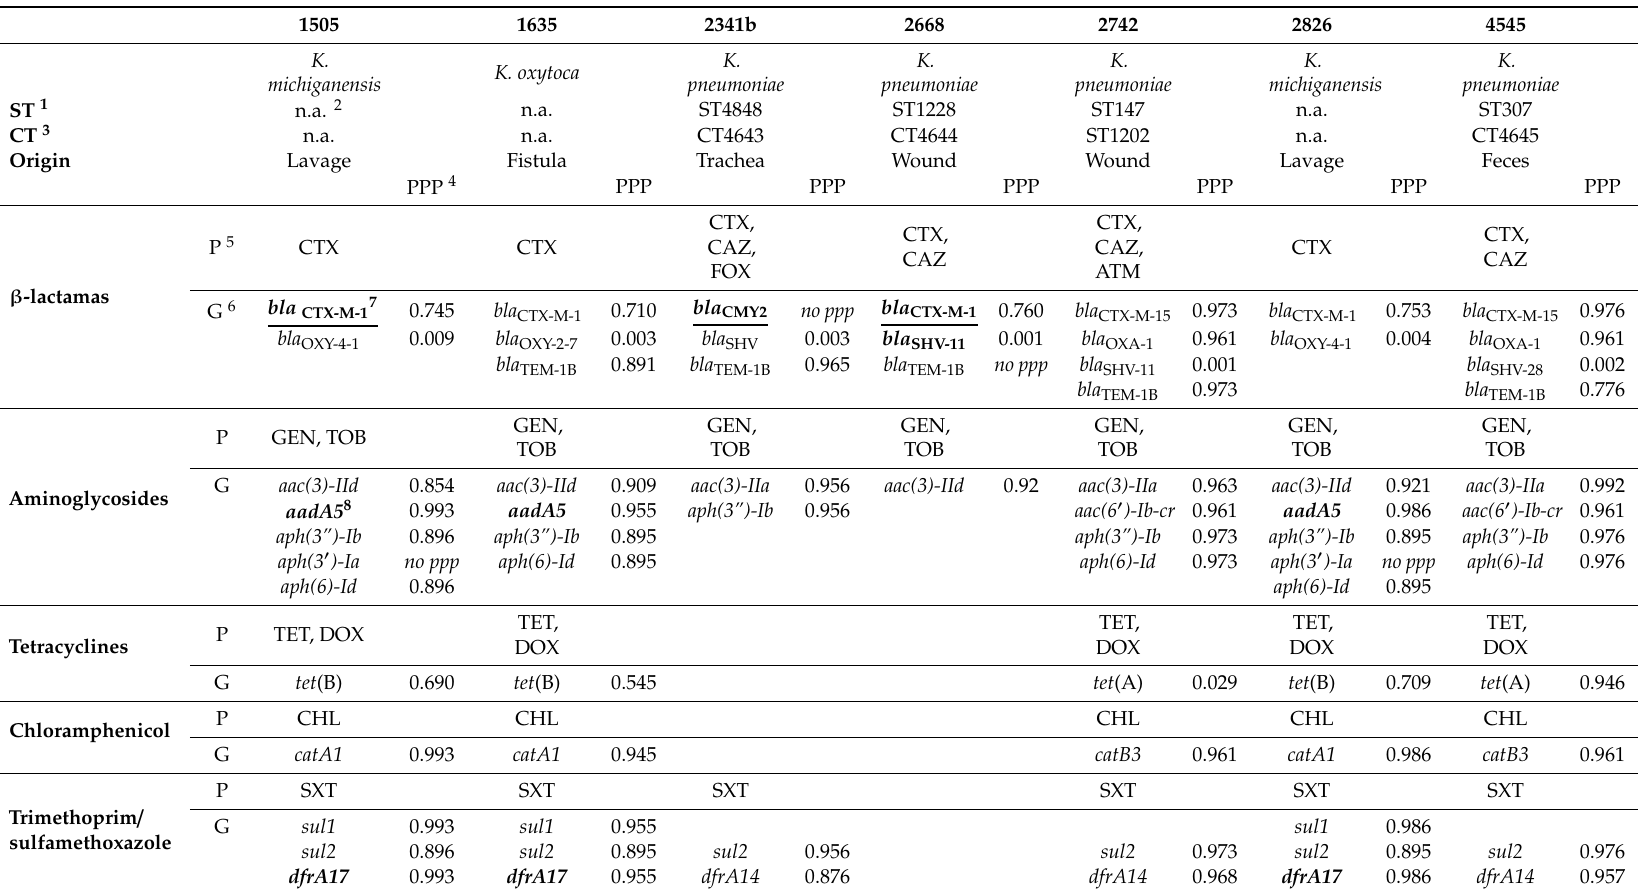
Table 1. Characteristics of seven examined cefotaxime-resistant Klebsiella